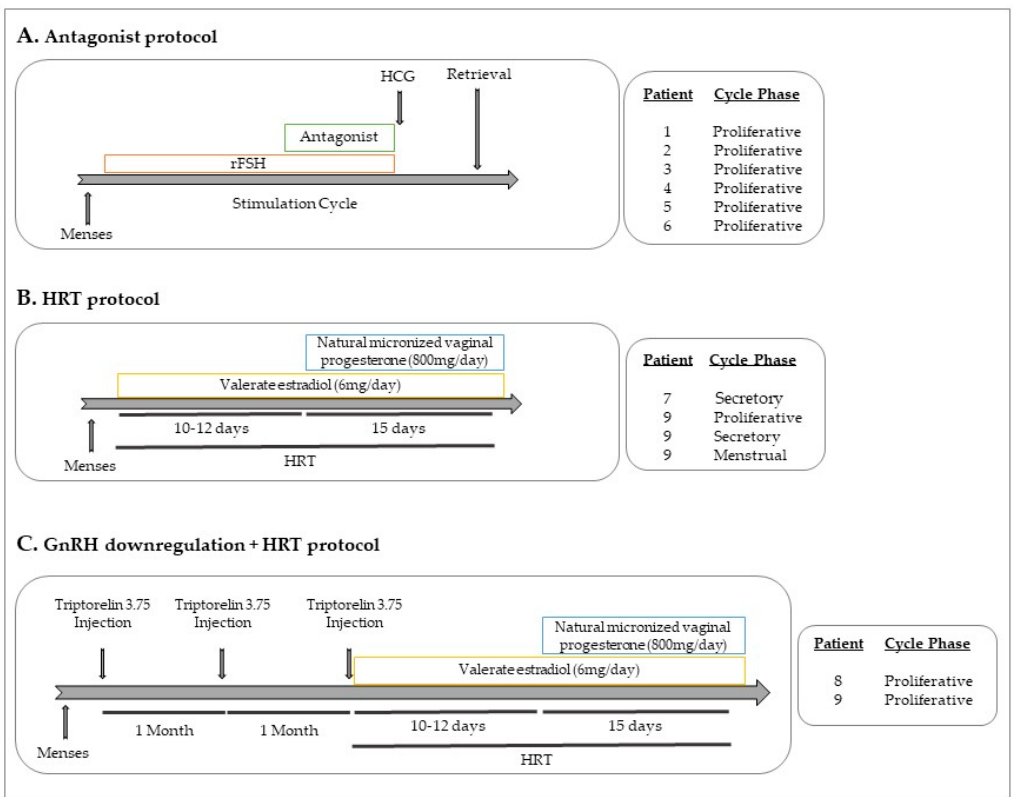
Figure 2. Hormonal treatments. ( A ) Antagonist protocol: After menses, rFSH is administrated for around 10–12 days. When the follicles reach around 12mm, the antagonist (GnRHAn) is administrated. At the end of the stimulation cycle, hCG is injected before the oocyte retrieval. ( B ) HRT protocol: After menses, valerate estradiol at oral dosages (6–8 mg / day) for 10–12 days is administrated. Then, 800 mg / day of natural micronized progesterone vaginally are added to the estradiol treatment for 15 more days. ( C )GnRHdownregulationprotocol + HRT:inlutealphase, oneinjectionoftriptorelin3.75(GnRHa) is administrated and subsequently for two more months. rFSH: recombinant follicle stimulating hormone; GnRHa: gonadotropin releasing hormone agonist; GnRHAn: gonadotropin